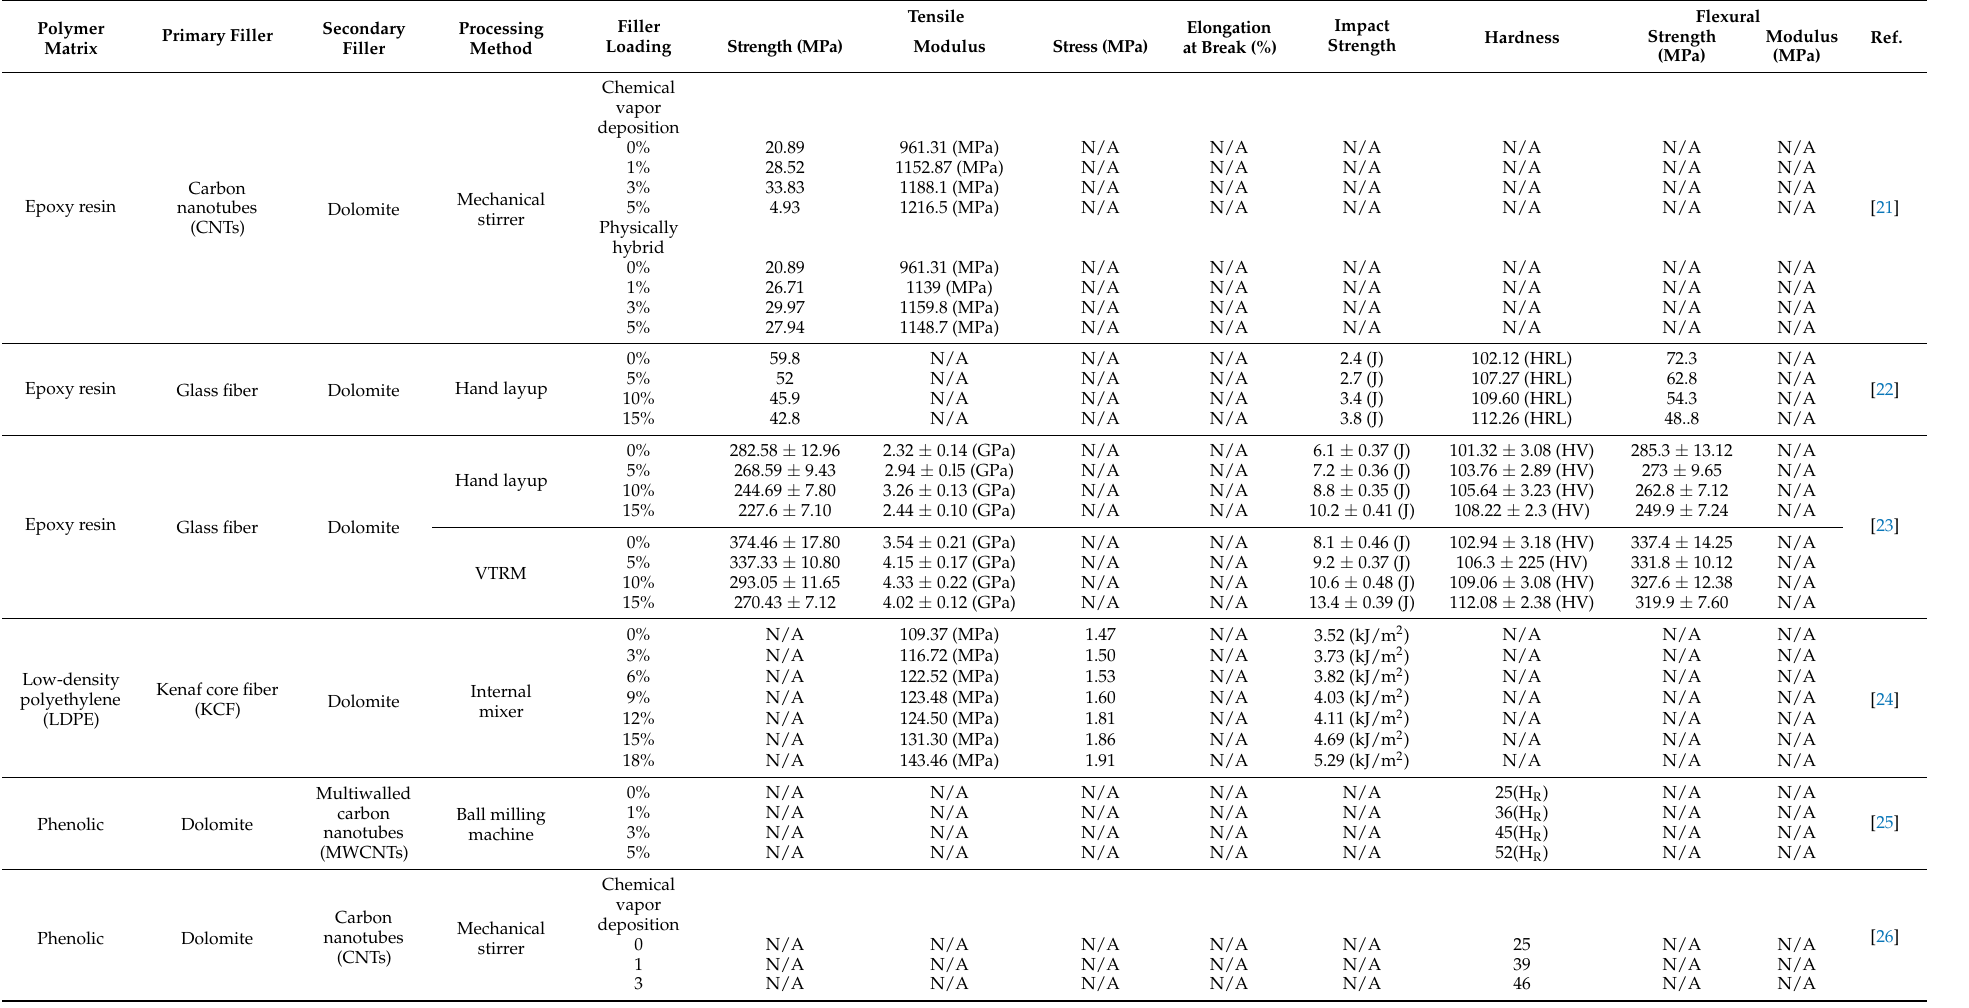
Table 6. Summary of literature studies reporting the use of dolomite as a co-filler/hybrid filler in polymer